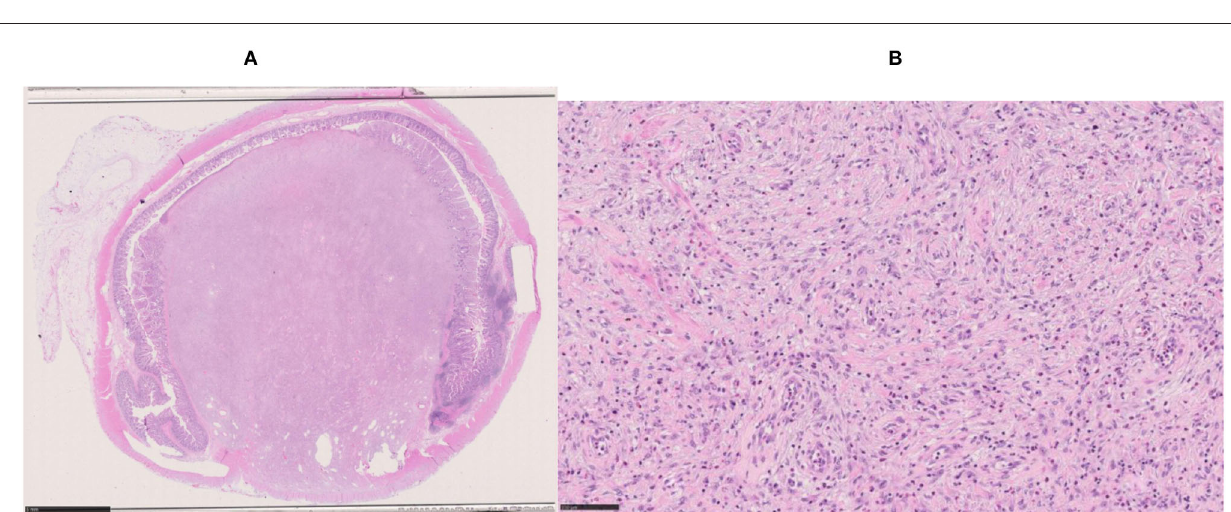
and size of the tumor. Abdominal pain is the most common symptom in patients with lesions in the stomach.